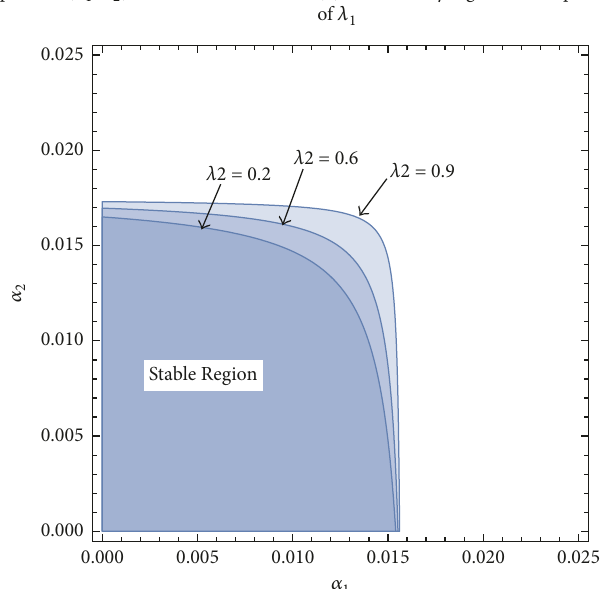
(a) The stability regions in the phase plane of (𝛼 1 ,𝛼 2 ) with different values of 𝜇